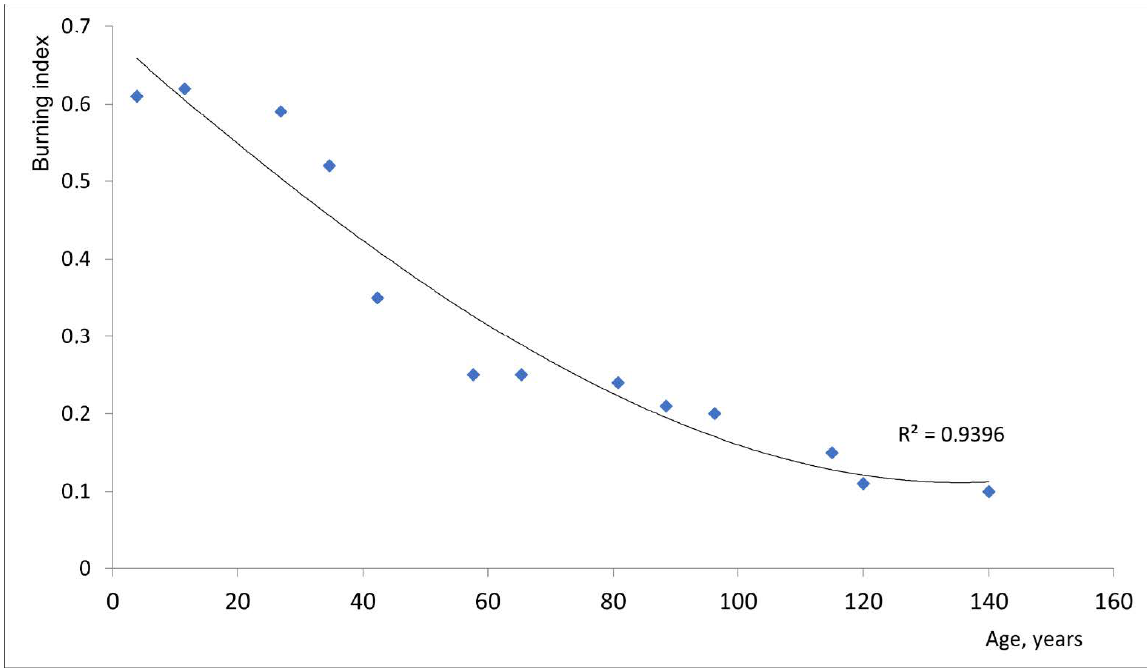
Figure 5. The dependence of burning indices on tree stand ages.